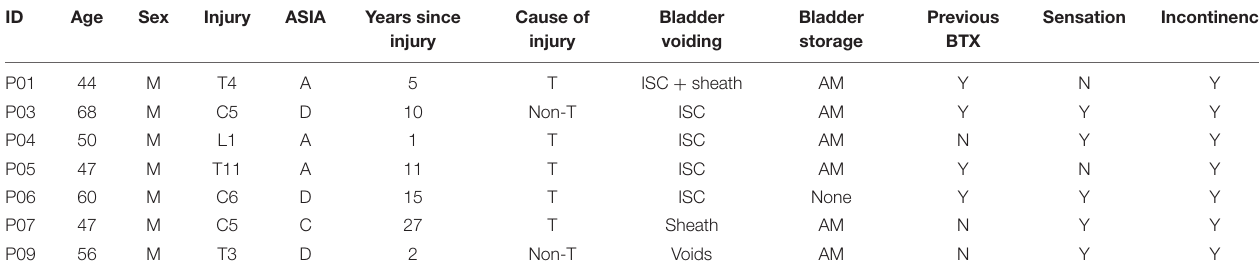
TABLE 1 | Participant characteristics with respect to injury level, ASIA grade, cause of injury (T, trauma, Non-T, not trauma) and age.